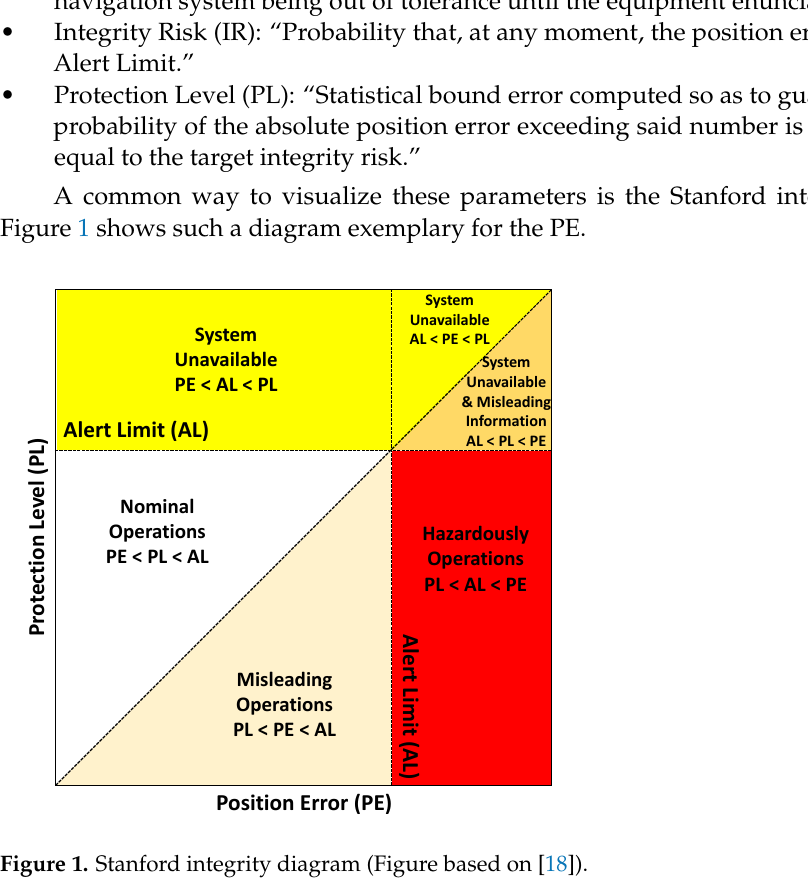
Figure 1. Stanford integrity diagram (Figure based on